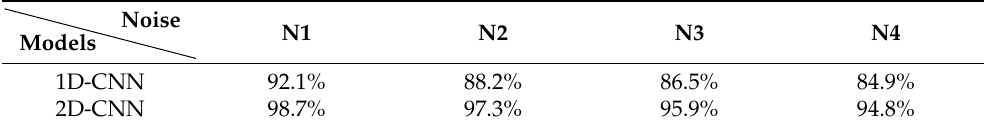
Figure 7. Classification accuracy of training sets. ( a ) 1D-CNN; ( b ) The proposed method. Table 4. The Classification Accuracy in Test Sets.